Question: Looking at the figure, what chart type is it?
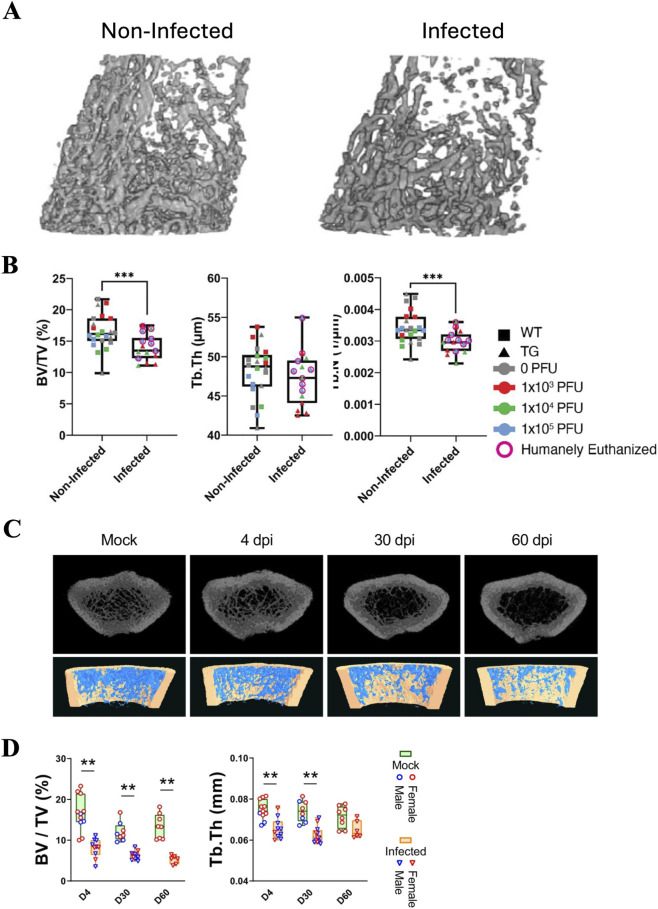
Answer: line